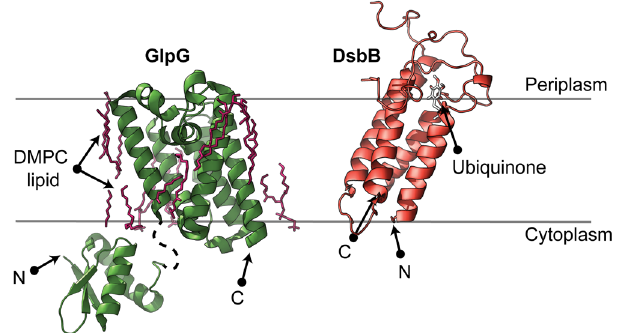
Figure 1. GlpG and DsbB protein structures. Crystal structures of GlpG (membrane domain PDB 2XTV; cytoplasmic N-terminal domain PDB 2LEP), with 6 TM helices and a soluble cytoplasmic domain (green, left), and DsbB (PDB 2LTQ) with 4 TM helices and a large periplasmic loop (red, right). The membrane boundaries (grey lines) and spatial arrangements for both membrane proteins were calculated by the orientations of proteins in membranes database (OPM) 52 . Both the N- and C-terminal ends of the crystal structure are labelled as N and C